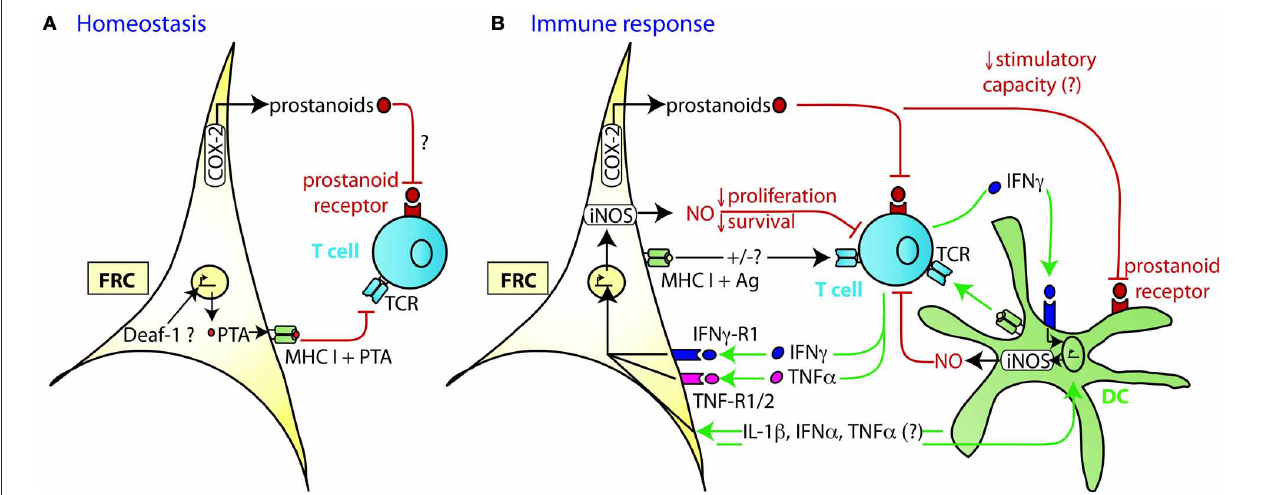
FIGURE 2 | Mechanism of TRC-mediated negative regulation of T cell expansion. (A) During homeostasis LN FRC express self-antigens (PTA), possibly in a Deaf-1 dependent fashion. PTA presented in the context of MHC I may lead to peripheral tolerance induction via clonal deletion of self-reactive T cells. Cox-2 is constitutively expressed in FRC, presumably leading to the production of PGE 2 or other prostanoids that may attenuate T cell priming or proliferation. (B) During immune response DC capture antigen (Ag) in the periphery, home to the T zone of SLO and present peptides of foreign antigens to recirculating T cells. Within the first 20h upon TCR triggering, T cells produce a first wave of IFN γ and TNF α cytokines, before entering cell cycle. In case of a very strong immune response, the high level of pro-inflammatory cytokines induces transient iNOS expression in